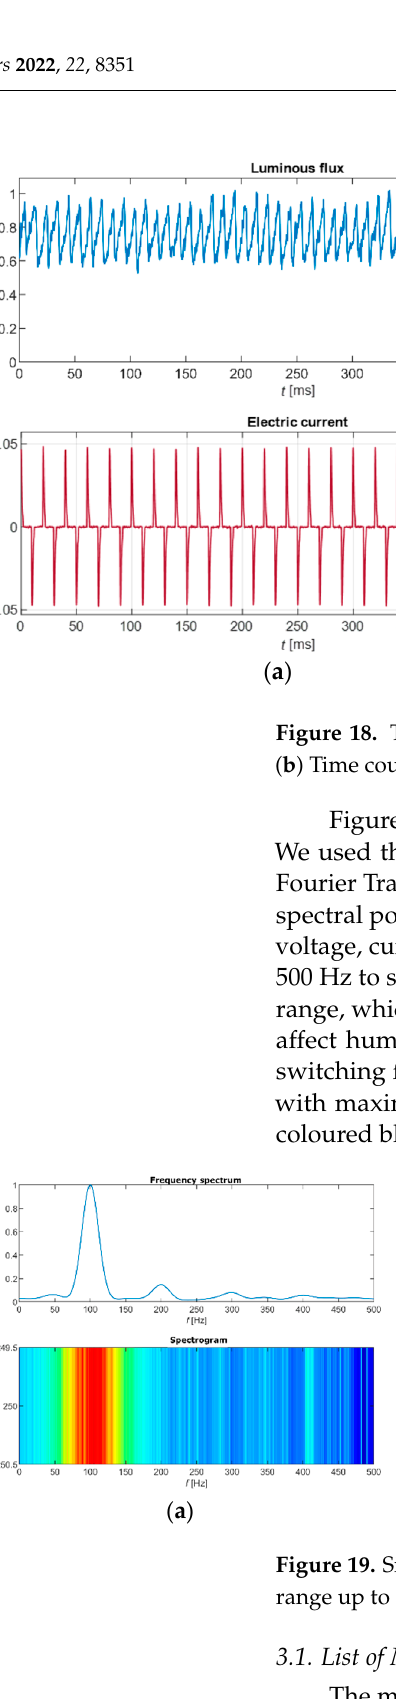
Table 1. List of measured LED light bulbs. Code nr.